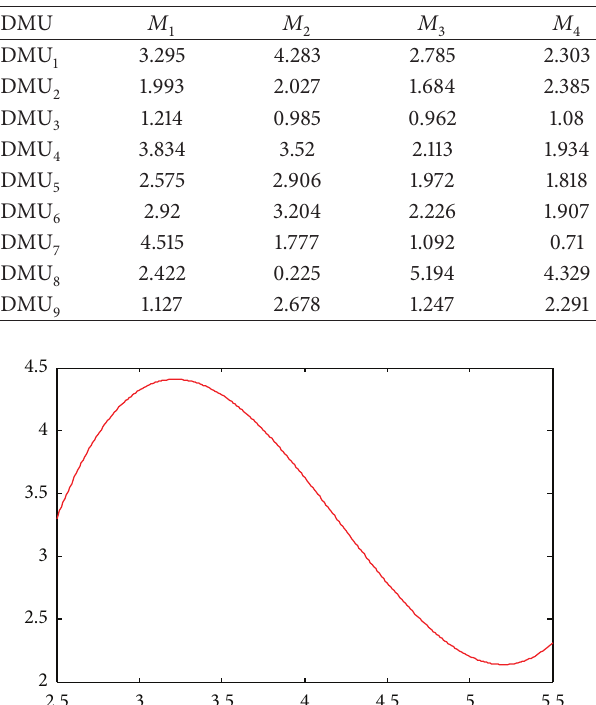
Table 11: The Malmquist productivity index.